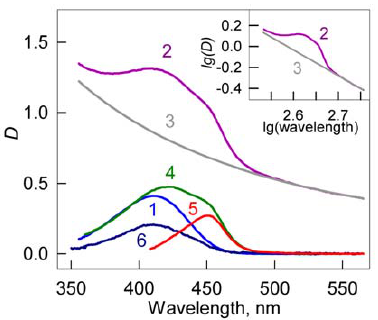
Figure 1. Absorption spectra of thioflavin T (ThT) incorporated in the amyloid fibril. Curves 1 and 2 represent absorption spectra of ThT in chamber # 1 (free ThT at concentration C f ) and in chamber # 2 (superposition of the absorption spectra of free ThT in concentration C f